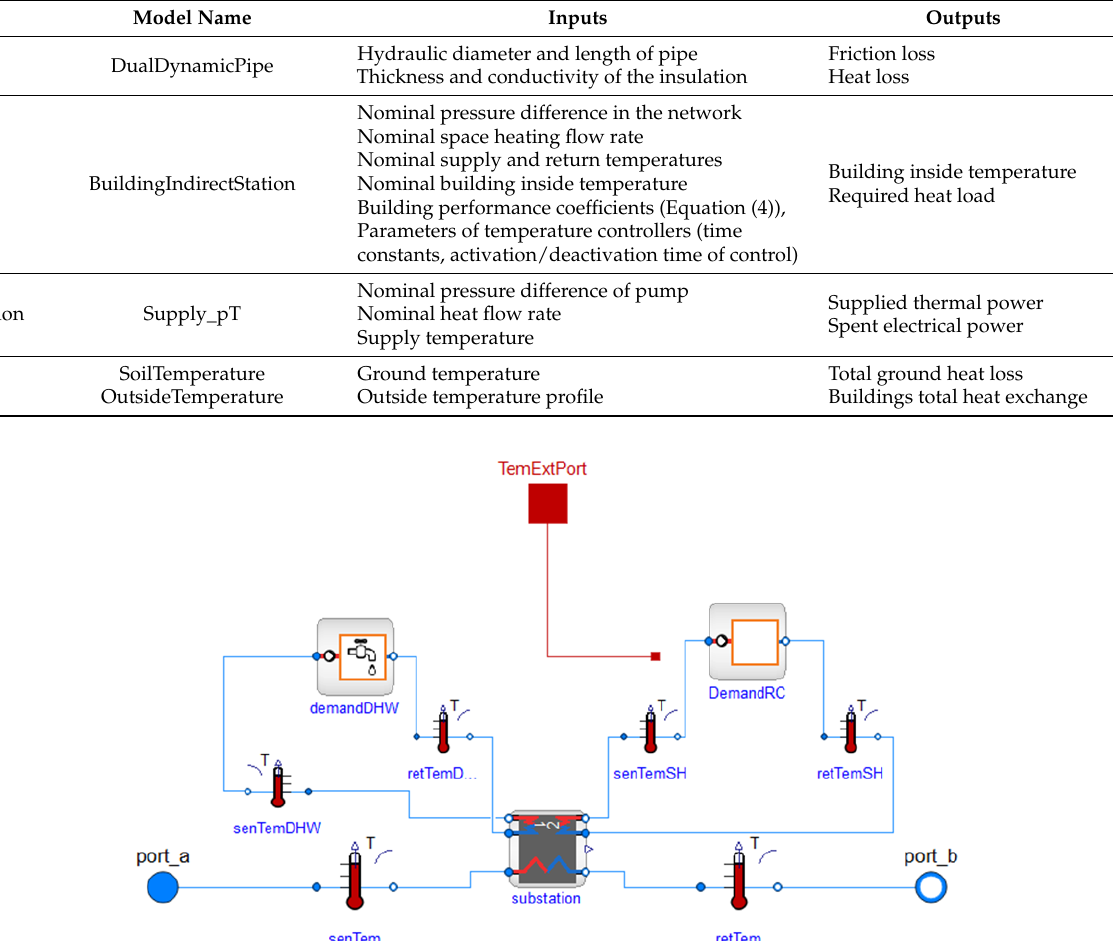
Table 1. Overview of the components used for modelling the network.